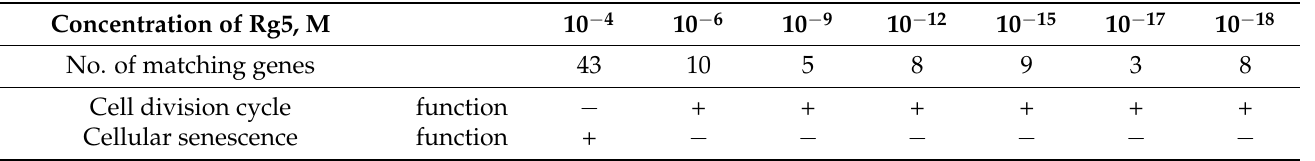
Table 3. The number of genes matching senescence signaling pathway and predicted effects of Rg5 in cellular processes associated with neurotransmission 1 .